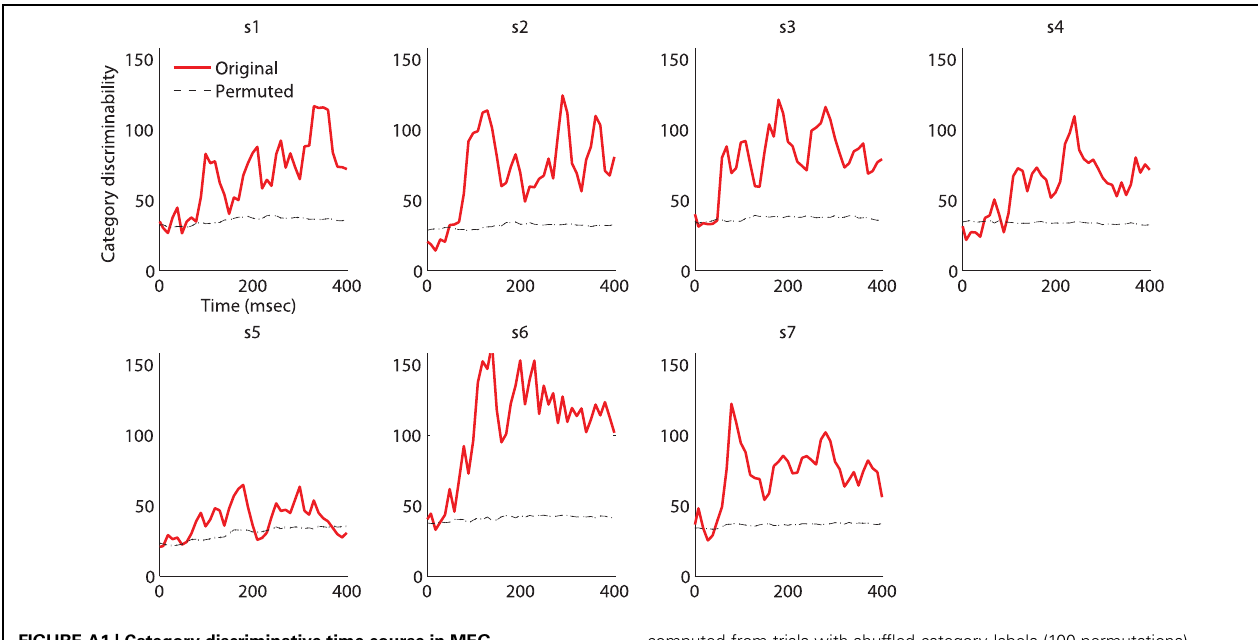
FIGURE A1 | Category-discriminative time course in MEG magnetometers. Individual category-discriminative time course (visual stimulus onset at 0ms) compared against discriminative time course